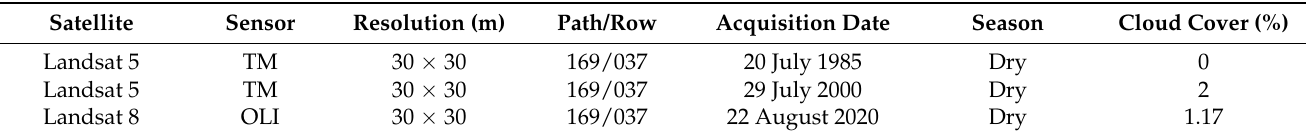
Table 1. RS data for LUCC